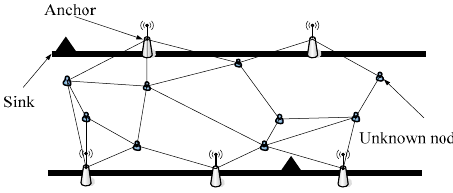
Figure 6. Process of target locating in belt-type sensor networks.